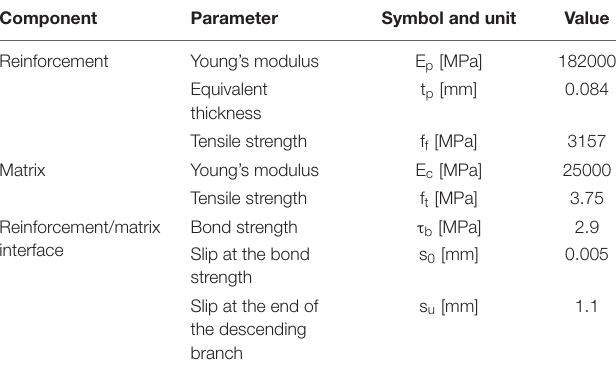
TABLE 1 | Parameters characterizing the accounted specimens. Component